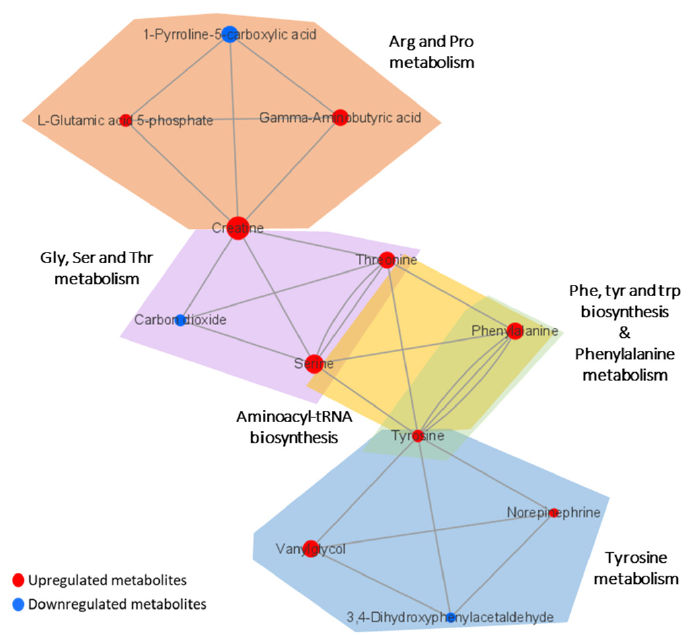
Figure 4. Network analysis presenting the connection between the metabolites in significantly altered pathways. The size of the nodes indicates the magnitude of the fold change. The red and blue colors indicate upregulation and downregulation, respectively.